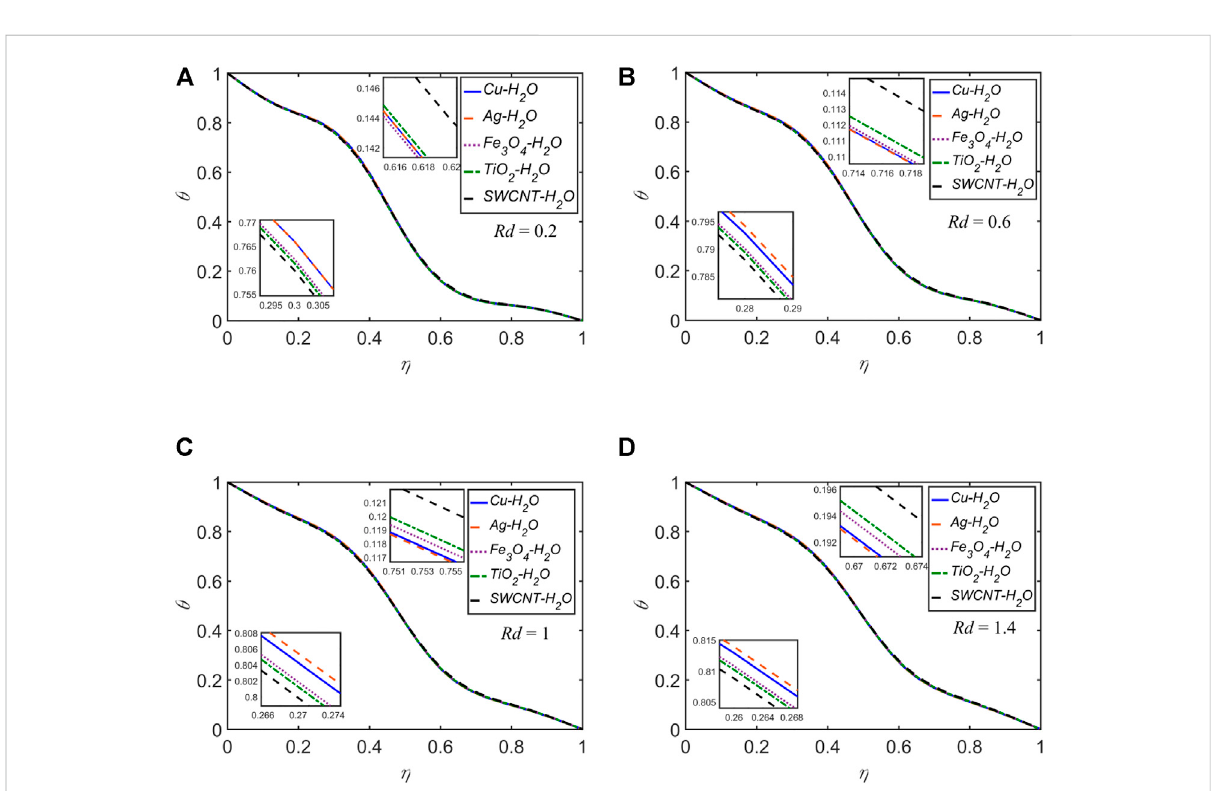
The temperature pro fi le θ versus η at x (cid:2) 2 and t (cid:2) 0 . 25 for the fi ve NFs for distinct values of Rd